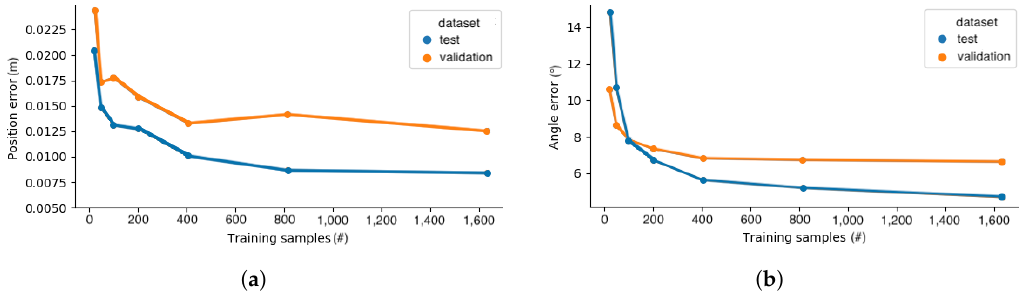
Figure 14. Number of training samples vs. ( a ) MAE position error. ( b ) MAE normal vector error.